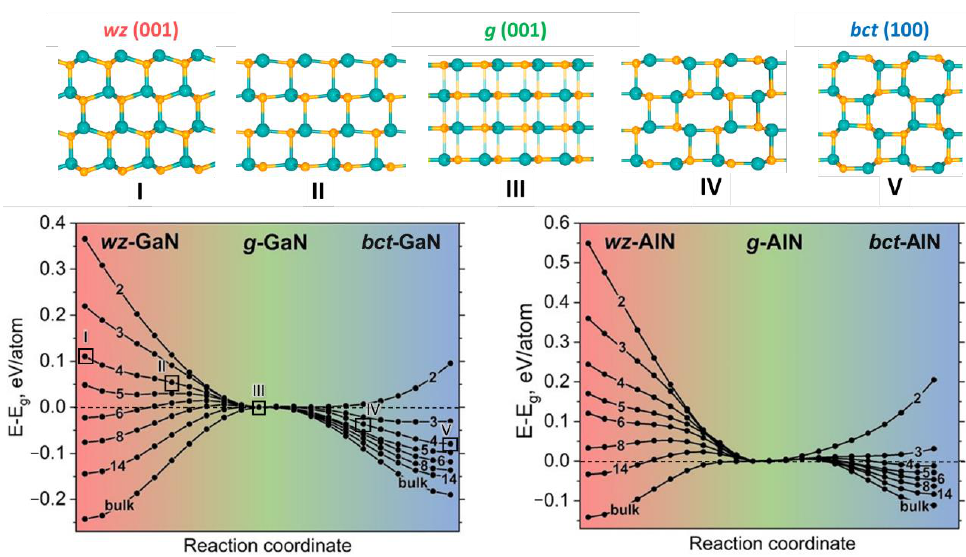
Figure 2. ( top ) The transition process from the wurtzite to the bct phase through graphene-like phase; ( bottom ) barriers of transformation of the GaN, AlN thin films from wz (001) to bct (100) structure. The energy of the graphene-like phase is taken as zero and marked by horizontal dashed line. The points corresponding to the top structures are marked by empty squares and the Roman numerals.